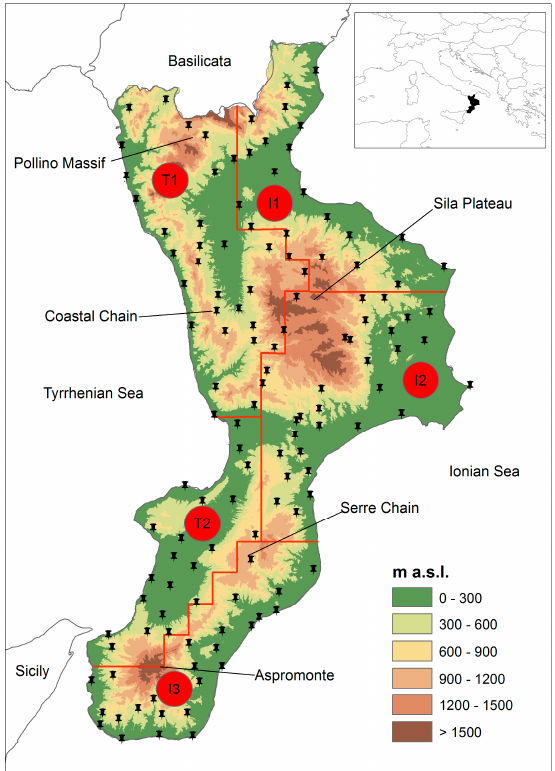
Figure 1. Localization of the selected 129 rain gauge stations and of the five Rainfall Zones on a DEM of